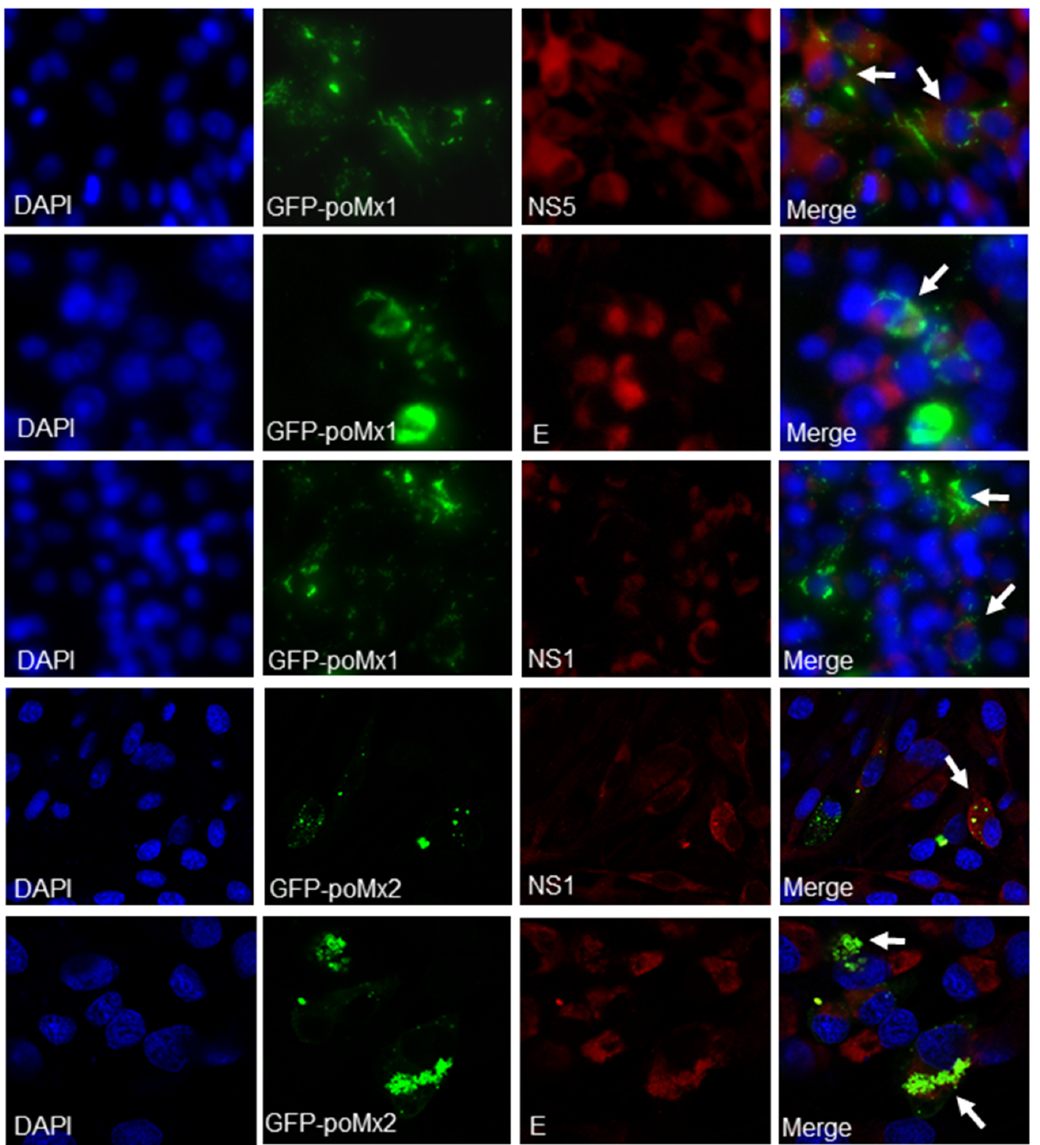
Figure 3. JEV replication in pEGFP-poMx1 or pEGFP-poMx2-transfected BHK-21 cells. Transfected cells grown on glass coverslips were infected with JEV at an MOI of 0.05. At 24 hpi, cells were washed with PBS and subjected to immunofluorescence assay. The cell nucleus was counterstained with DAPI (blue). White arrows indicate cells with high GFP-poMx1 or GFP-poMx2 expression levels along with high JEV viral proteins (NS1, NS5, or E).